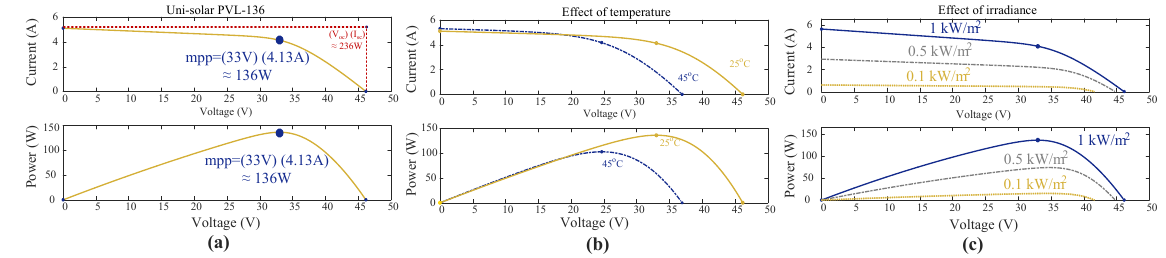
Figure 9. Characteristics of the PVL-136 panel: ( a ) the current voltage and power voltage curves in the standard test conditions. The MPP in the standard test condition is about 136 W. ( b ) The effect of temperature on the the performance of the PV panel. ( c ) The effect of the solar irradiance level on the performance of the PV panel.